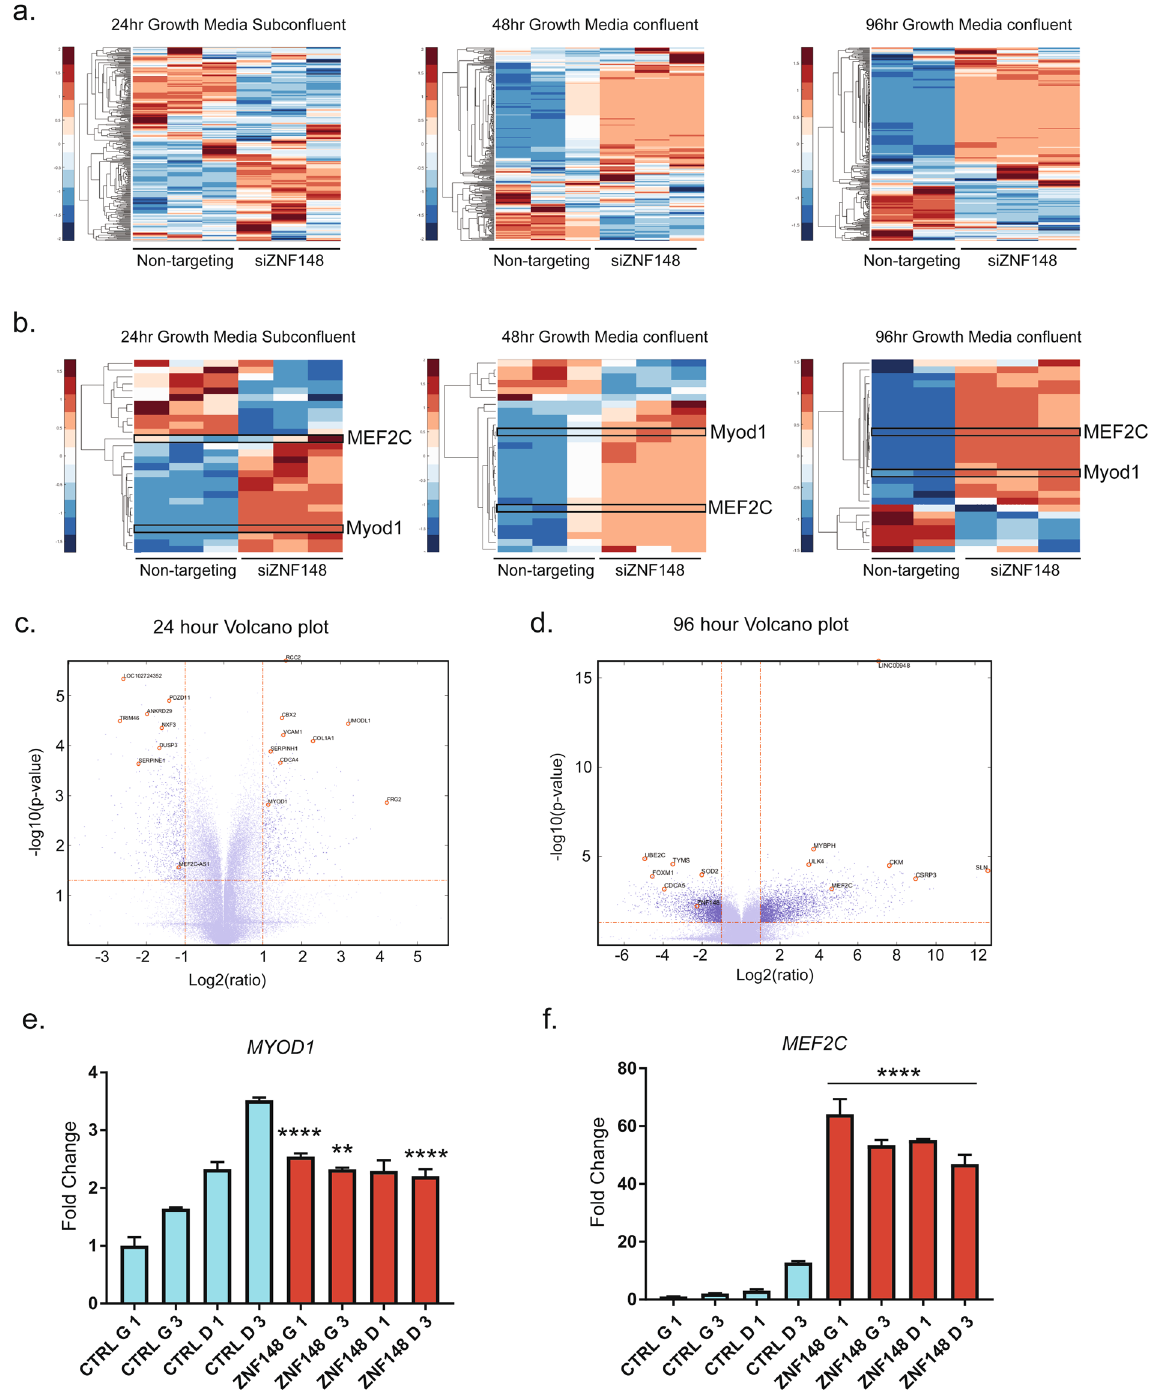
Figure 4. Microarray analysis reveals prominent muscle transcription factors are upregulated within 24 hours of ZNF148 knockdown. ( a ). Microarray clustergram of 269 muscle genes in LHCN-M2 cells cultivated for 24 hours (subconfluent), 48 hours (confluent), or 96 hours (confluent) in growth media. Nontargeting siRNA was compared with ZNF148 siRNA. ( b ) Microarray clustergram of the statistically significant ( P < 0.05) muscle genes in LHCN-M2 cells cultivated for 24 hours in growth media (subconfluent). The same genes are shown for cells cultivated for 48 hours (confluent) and 96 hours (confluent) in growth media. Nontargeting siRNA was compared with ZNF148 siRNA. Volcano plots of LHCN-M2 cells grown for ( c ) 24 hours and ( d ) 96 hours. The plots illustrate all of the top hits from the microarray analysis at indicated times. ( e ) MYOD expression in LHCN-M2 cells transfected with either nontargeting siRNA or ZNF148 siRNA in growth media (G) or differentiation media (D) for 1 or 3 days (G1, G3, D1 and D3). ( f ) MEF2C expression in LHCN-M2 cells treated with the conditions described in ( e ). ** P < 0.01, *** P < 0.001, **** P <